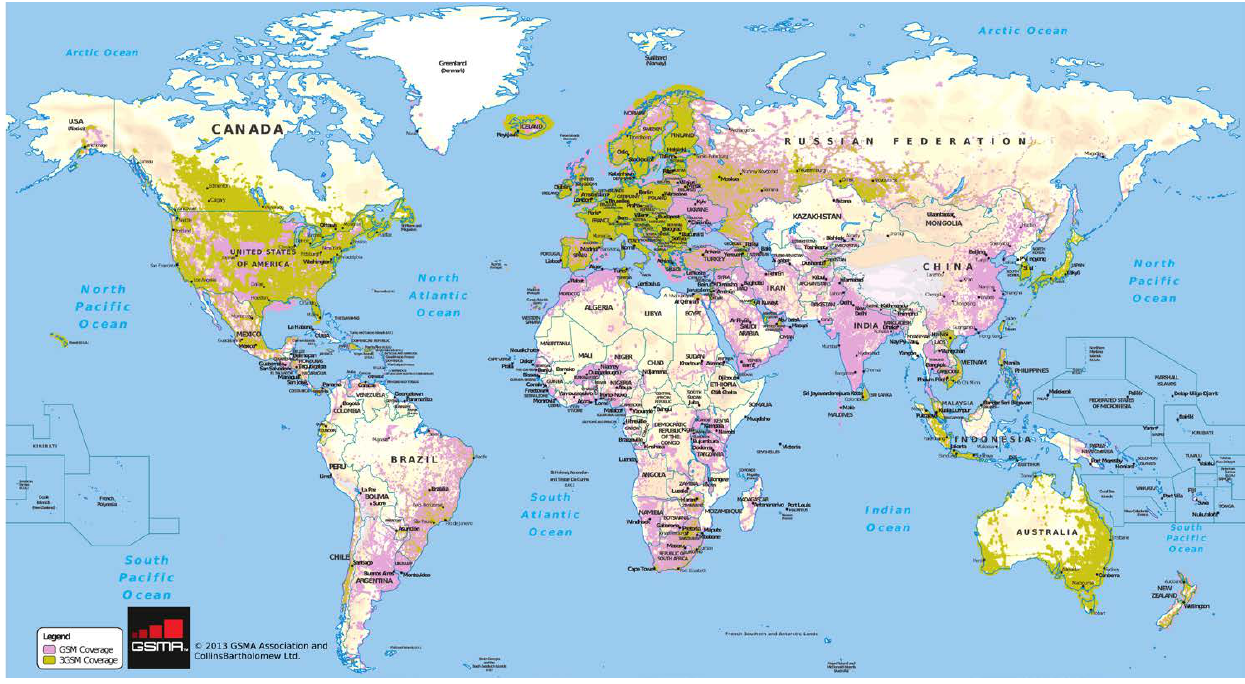
Figure 5. Worldwide global system for mobile communication (GSM) coverage for the year 2013. The GSM network does not include the growth of related 3G or 4G networks. The image is derived from Fig. 2 in Overeem et al.